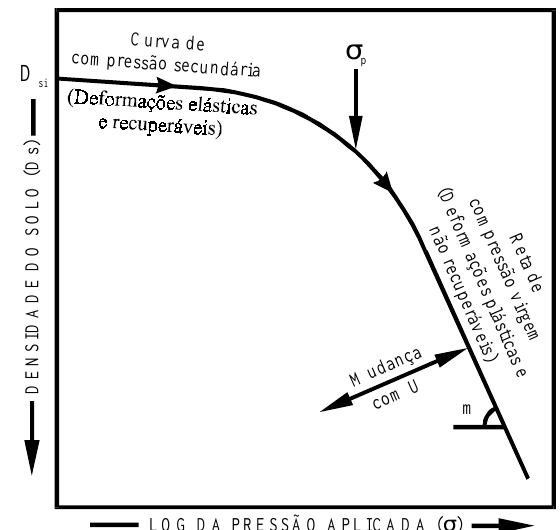
Figura 1. Exemplo de curva de compressão do solo, de acordo com Dias Junior (1994).